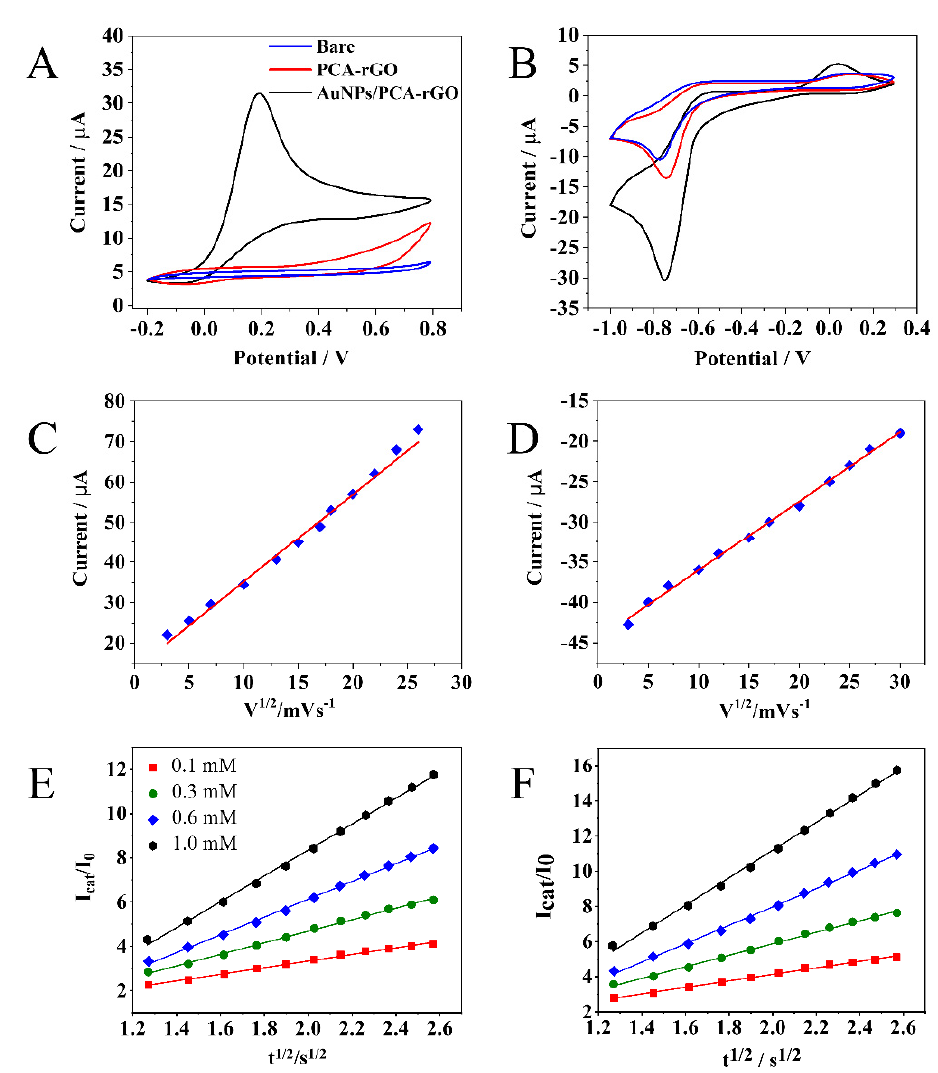
Figure 2. CV scans recorded at the SPCEs, PCA-rGO/SPCEs, and AuNPs/PCA-rGO/SPCEs, at 100 mV s − 1 , in 0.1 mM PBS buffer (pH 7.4), ( A ) 1 mM in N 2 H 4 , from − 0.2 V to 0.7 V, and ( B ) 1 mM in 4-NP, from − 1 V to 0.3 V. Oxidation currents of N 2 H 4 at +0.15 V ( C , E ) and reduction currents of 4-NP at − 0.71 V ( D , F ) at the AuNPs/PCA-rGO/SPCEs, between 100–500 mV s − 1 , versus square root of scan rate ( C , D ) and versus square root of time ( E , F ), in the 0.1–1 mM range in 0.1 M PBS buffer solutions (pH 7.4).